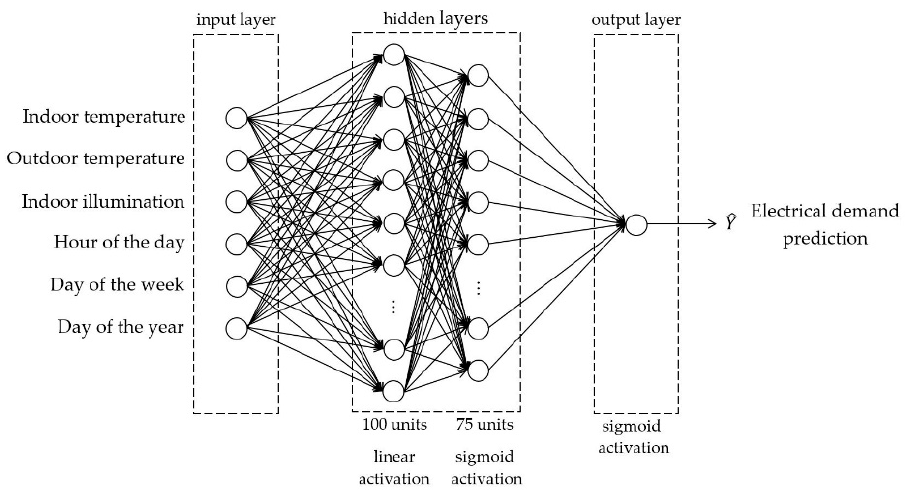
Figure 4. Best configuration of the SNN model in the office building tested.